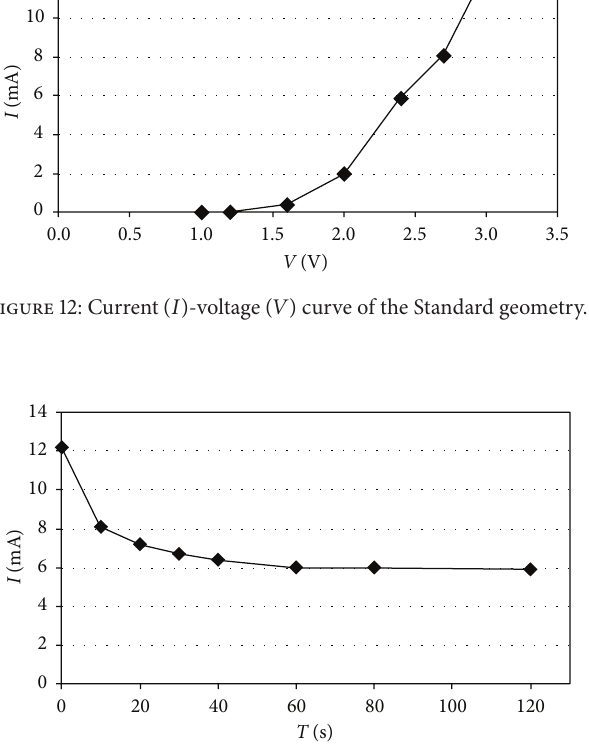
Figure13:TemporalchangeinthecurrentoftheStandardgeometry at